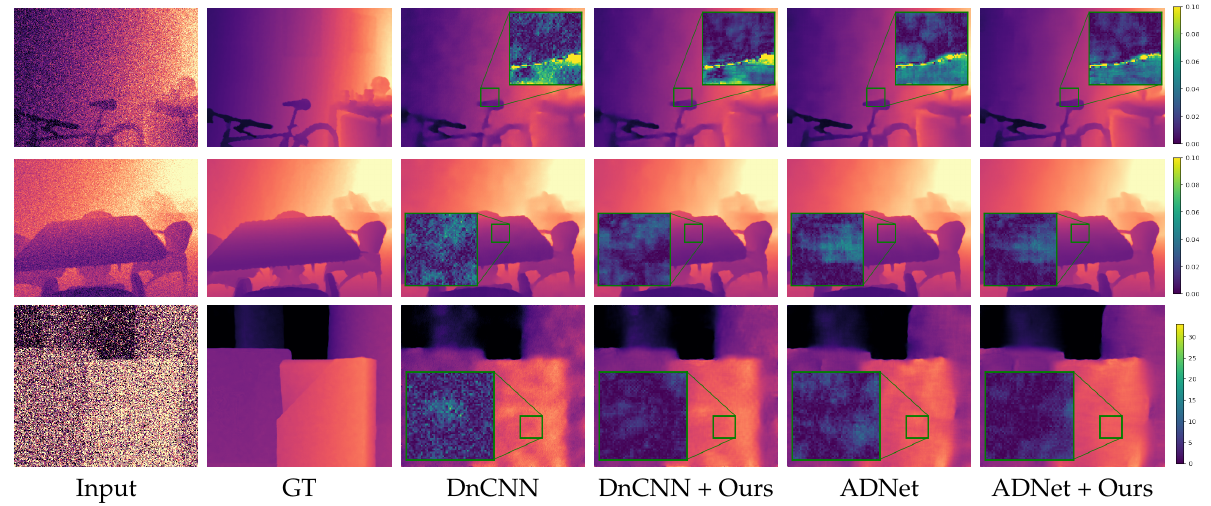
Figure 2. Denoising results. Insets show absolute difference to ground truth. The first two rows are examples from the NYU v2 [33] test set and the third row from the Middlebury dataset [37]. Note that while we, like other authors, show input and result of the Middlebury example as pixel disparity values, we add the noise to the converted depth maps.